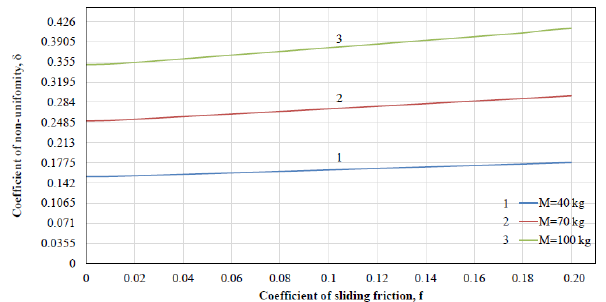
Figure 13. Dependences of coefficient of non-uniformity of rota- tion δ from coefficient of sliding friction f at coefficient of rota- tional friction k = 0 and for different values of load mass M